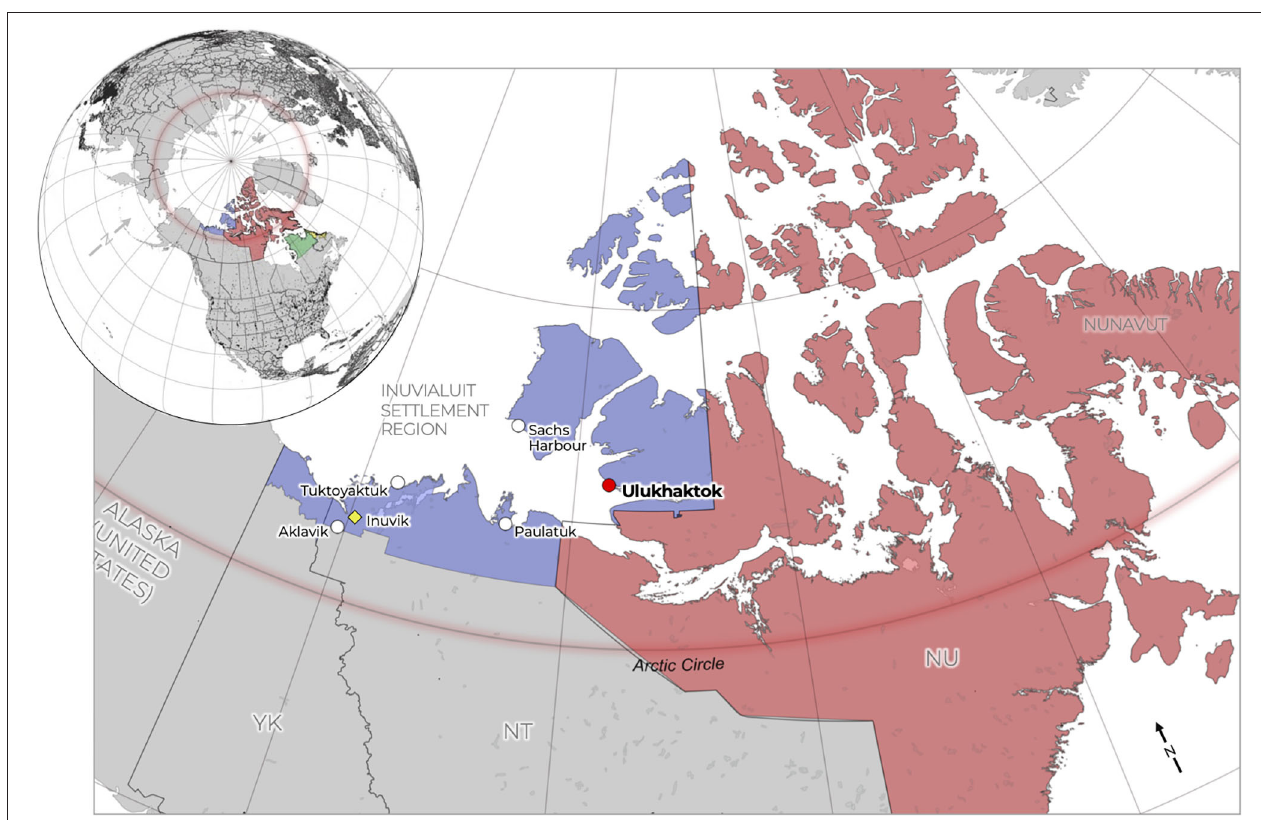
FIGURE 1 | Map of Inuit Nunangat (coloured sections), showing Ulukhaktok and the other five communities within the Inuvialuit Settlement Region. Contains information licensed under the Open Government